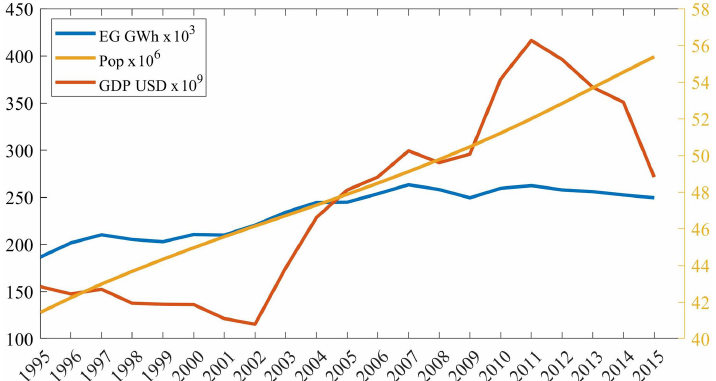
Figure A4. South African population (Pop) and GDP from 1995 to 2015 (World Bank, 2019), as well as electricity generation (EG) during this period (International Energy Agency,